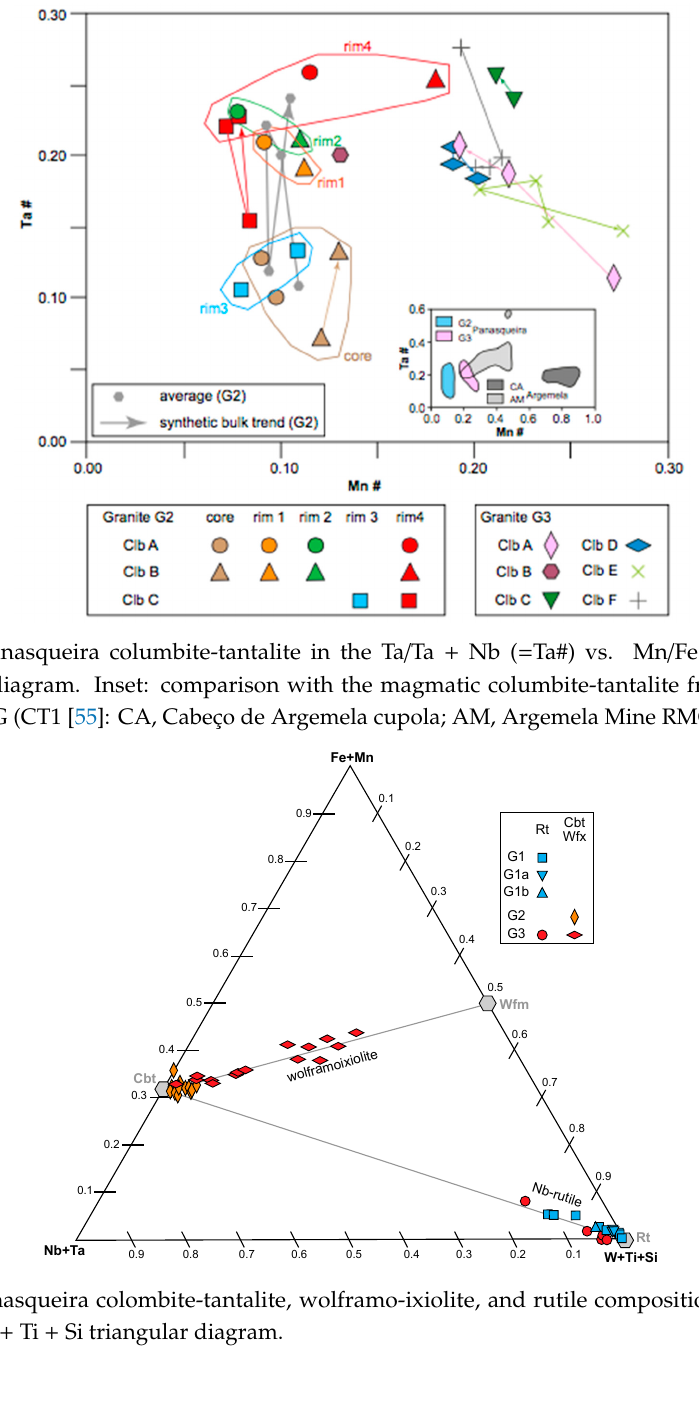
Minerals 2020 , 10 , x FOR PEER REVIEW 27 of 46